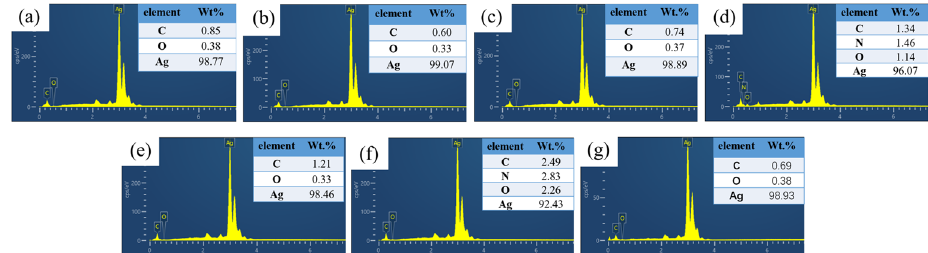
Figure 6. EDS results sintered products of different MOD: ( a ) MOD1, ( b ) MOD2, ( c ) MOD3, ( d ) MOD4, ( e ) MOD5, ( f ) MOD6, ( g ) MOD7.